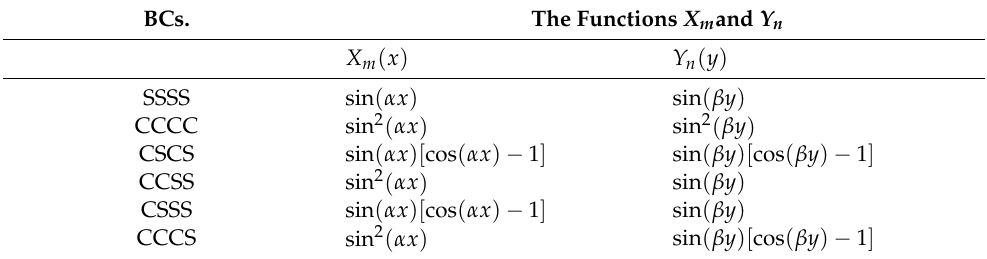
Table 1. The admissible functions X m ( x ) and Y n ( y ) . BCs.